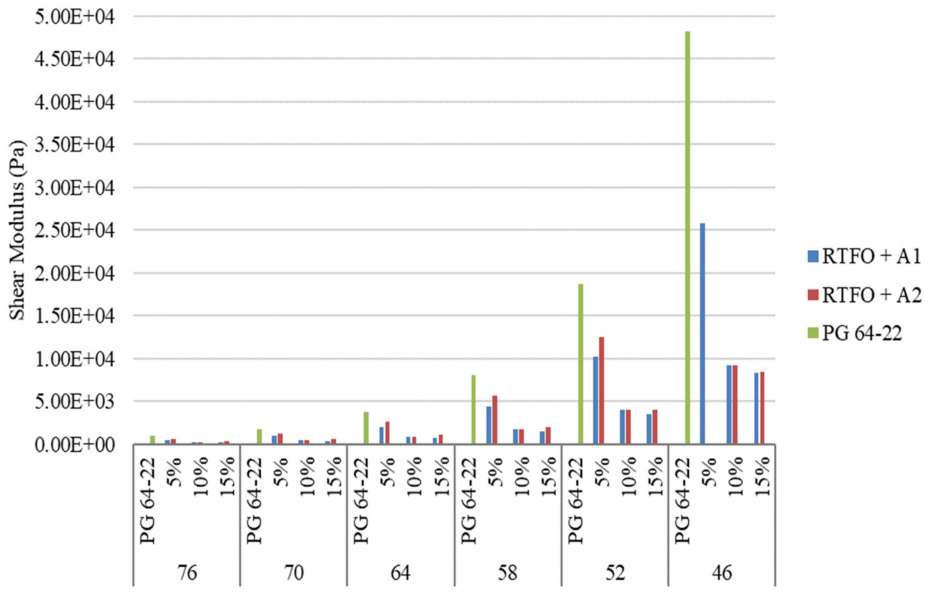
Figure 4. Dynamic modulus of the RTFO aged samples with the additives of A1 and A2.